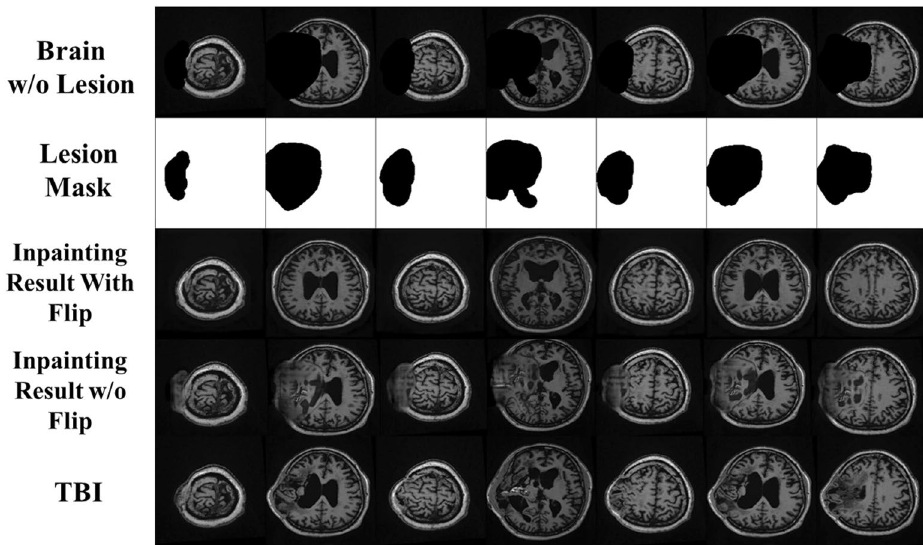
Fig. 4 Exemplary brain inpainting results for the images from hydrocephalus patients. Row 1 shows the input images, and row 2 shows the input image without the lesion region (erase mask) presented in row 3. Rows 4 and 5 show the output of the inpainting network without and with the flipping